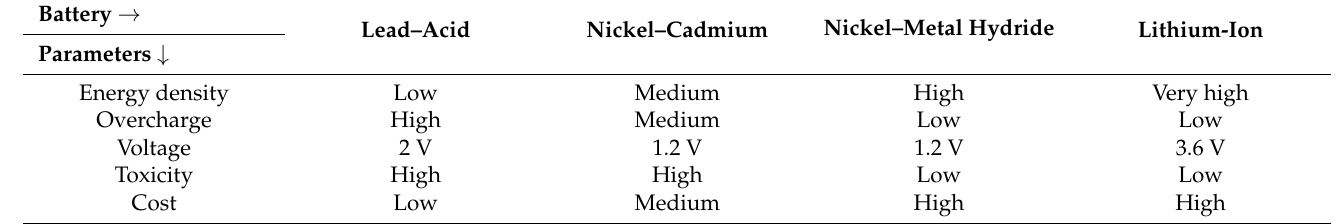
Table 2. Comparison of